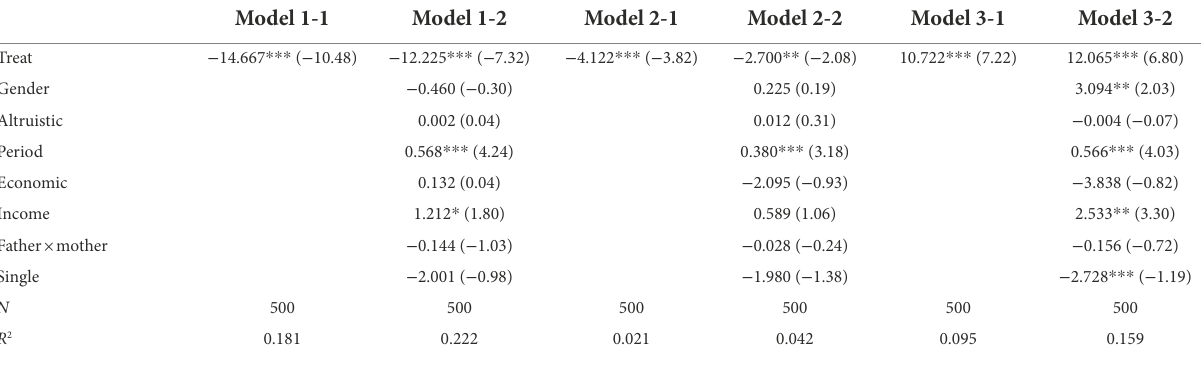
TABLE 6 Individual payoff with or without leaders.